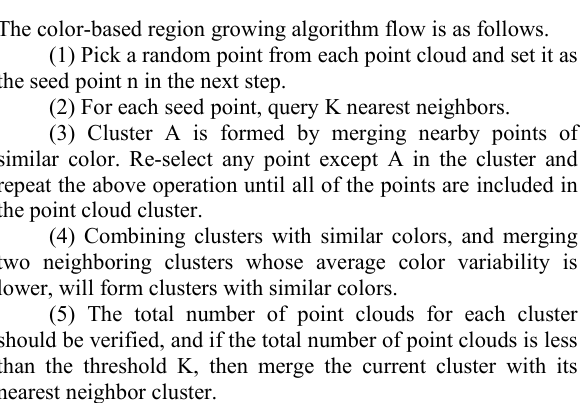
Figure 5. Color region based growth segmentation process. Figure 6. Schematic diagram of label resegmentation